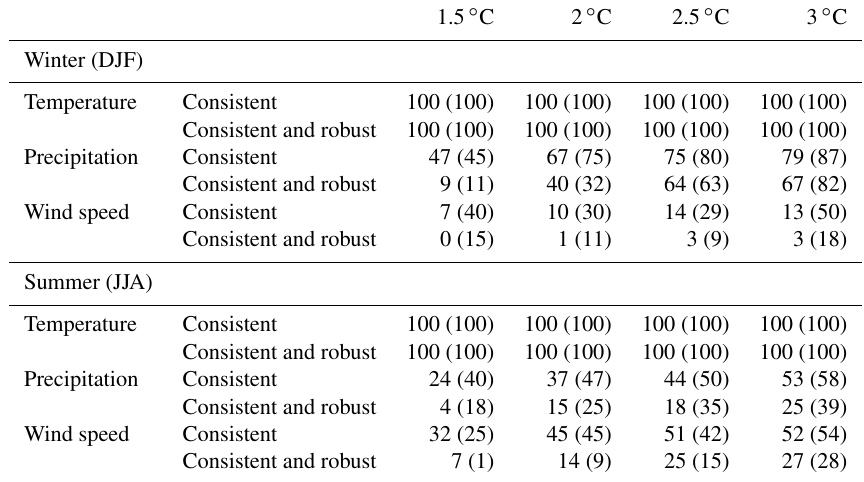
Table 3. Summary statistics showing the fraction of land in the larger European domain (see Fig. 1) where the ensemble members show consistent changes (80% agree on sign) and in addition show a robust change for four different warming levels between 1.5 and 3 ◦ C as defined in Sect. 2.3. The numbers in parentheses represent the corresponding fraction from the underlying GCM